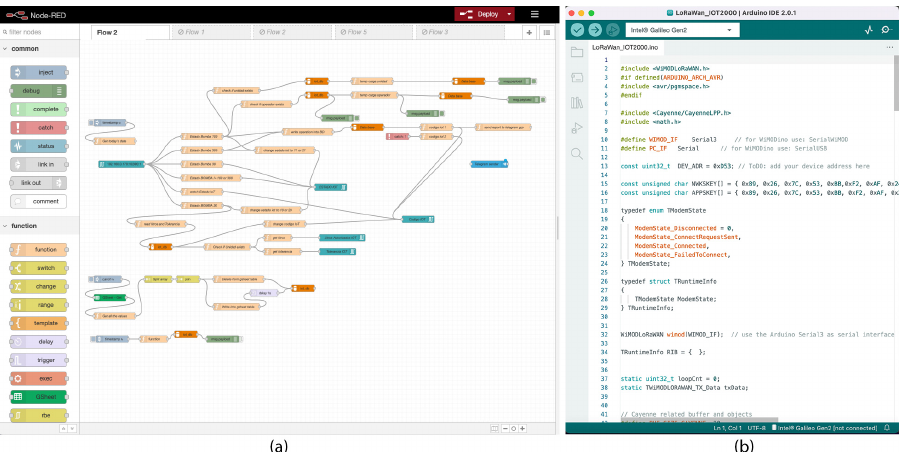
Figure 3. ( a ) NodeRed dashboard, it provides a browser-based editor that makes it easy to wire together flows using the nodes. ( b ) a part of the code used to program the LoRaWan communication of the SIMATIC